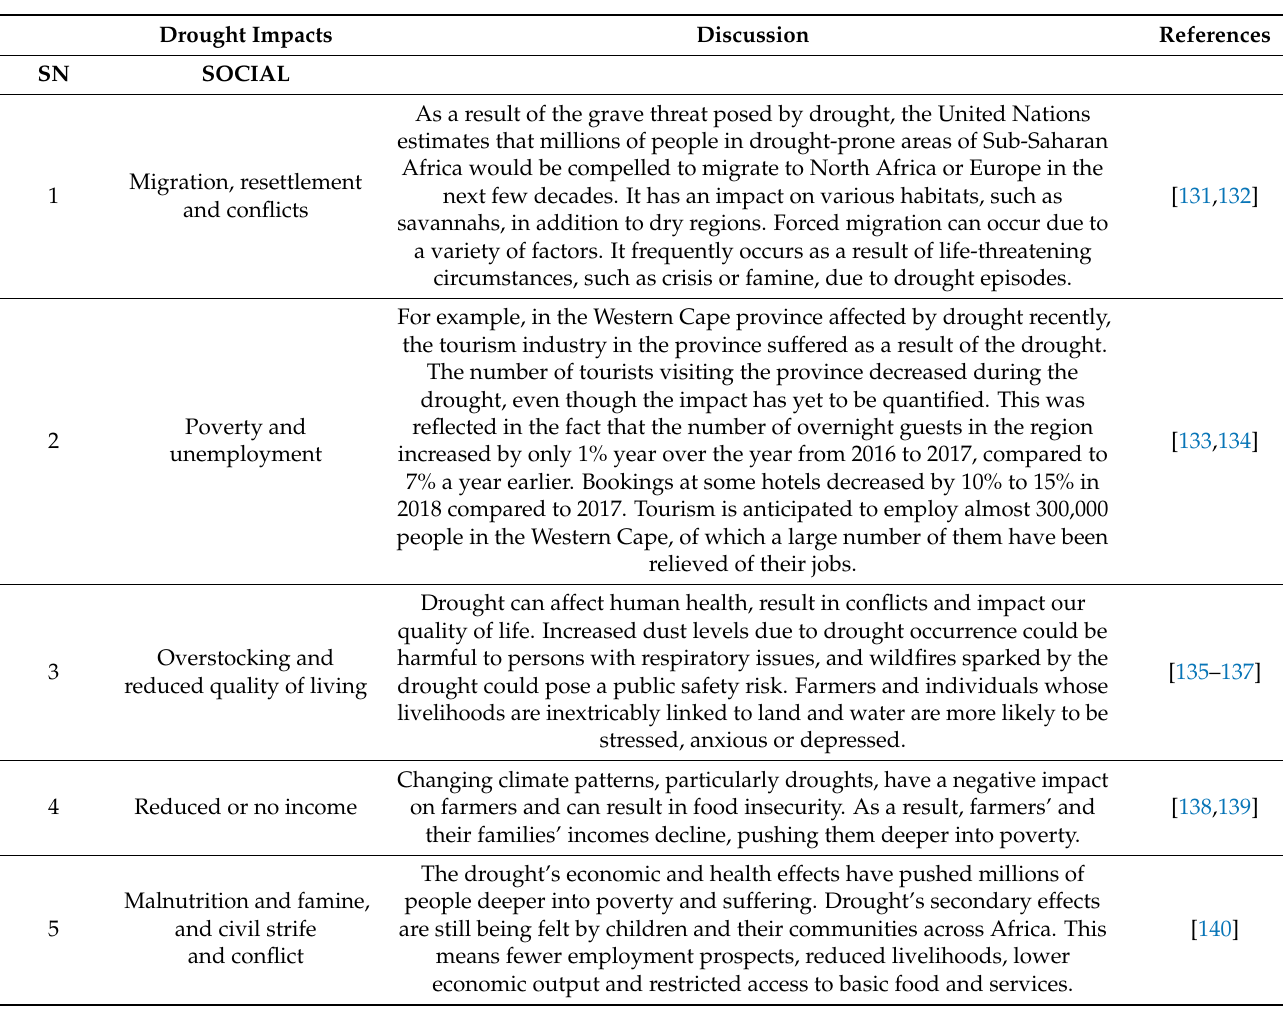
Table 1. Drought